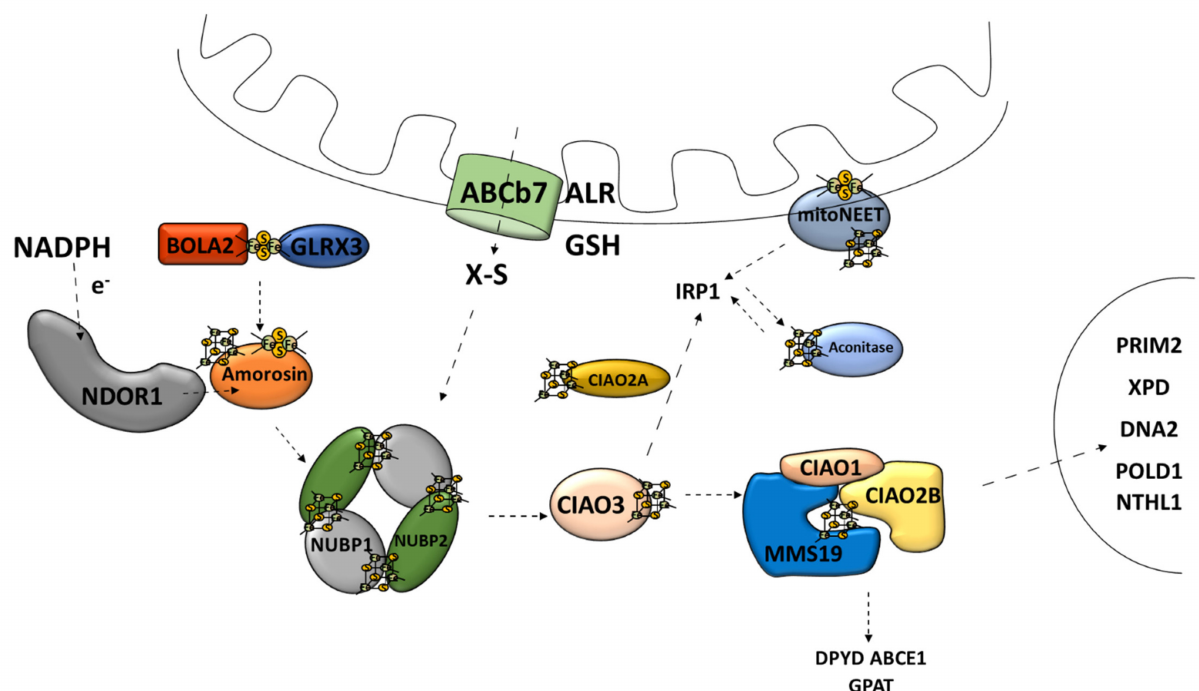
Figure 5. Cytosolic [4Fe–4S] iron–sulfur cluster assembly and targeting machinery. ABCb7, ATP-binding cassette (ABC) transporter family; ALR, mitochondrial FAD-linked sulfhydryl oxidase; GSH, reduced glutathione; X–S, unidentified X–S compound; NDOR1, diflavin oxidoreductase 1; Amorosin, Fe–S cluster assembly protein DRE2 homolog; BOLA2, bolA family member 2; GLRX3, glutaredoxin 3; NUBP1, cytosolic Fe–S cluster assembly factor NUBP1; NUBP2, cytosolic Fe–S cluster assembly factor NUBP2; IOP1/CIAO3, cytosolic iron–sulfur assembly component 3; CIAO1, cytosolic iron–sulfur protein assembly protein CIAO1; CIAO2B, cytosolic iron–sulfur assembly component 2B; MMS19, cytosolic iron–sulfur assembly component MMS19; Aconitase/IRP1, aconitase 1; DPYD, dihydropyrimidine dehydrogenase; ABCE1, ATP binding cassette subfamily E member 1; GPAT, glutamine phosphoribosyl-pyrophosphate amidotransferase; POLD1, DNA polymerase δ ; NTHL1, DNA base-excision repair enzyme; XPD, general transcription and DNA repair factor IIH helicase subunit XPD; RTEL1, regulator of telomere elongation helicase 1; DNA2, DNA replication helicase/nuclease 2; PRIM2, DNA primase subunit